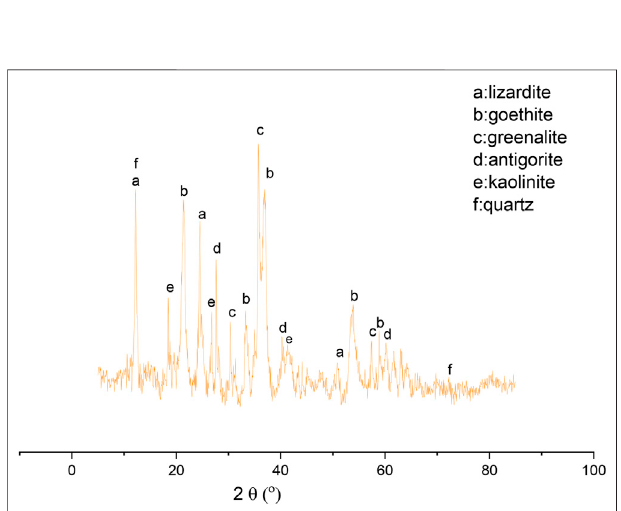
FIGURE 1 | XRD pattern of the nickel laterite ore.